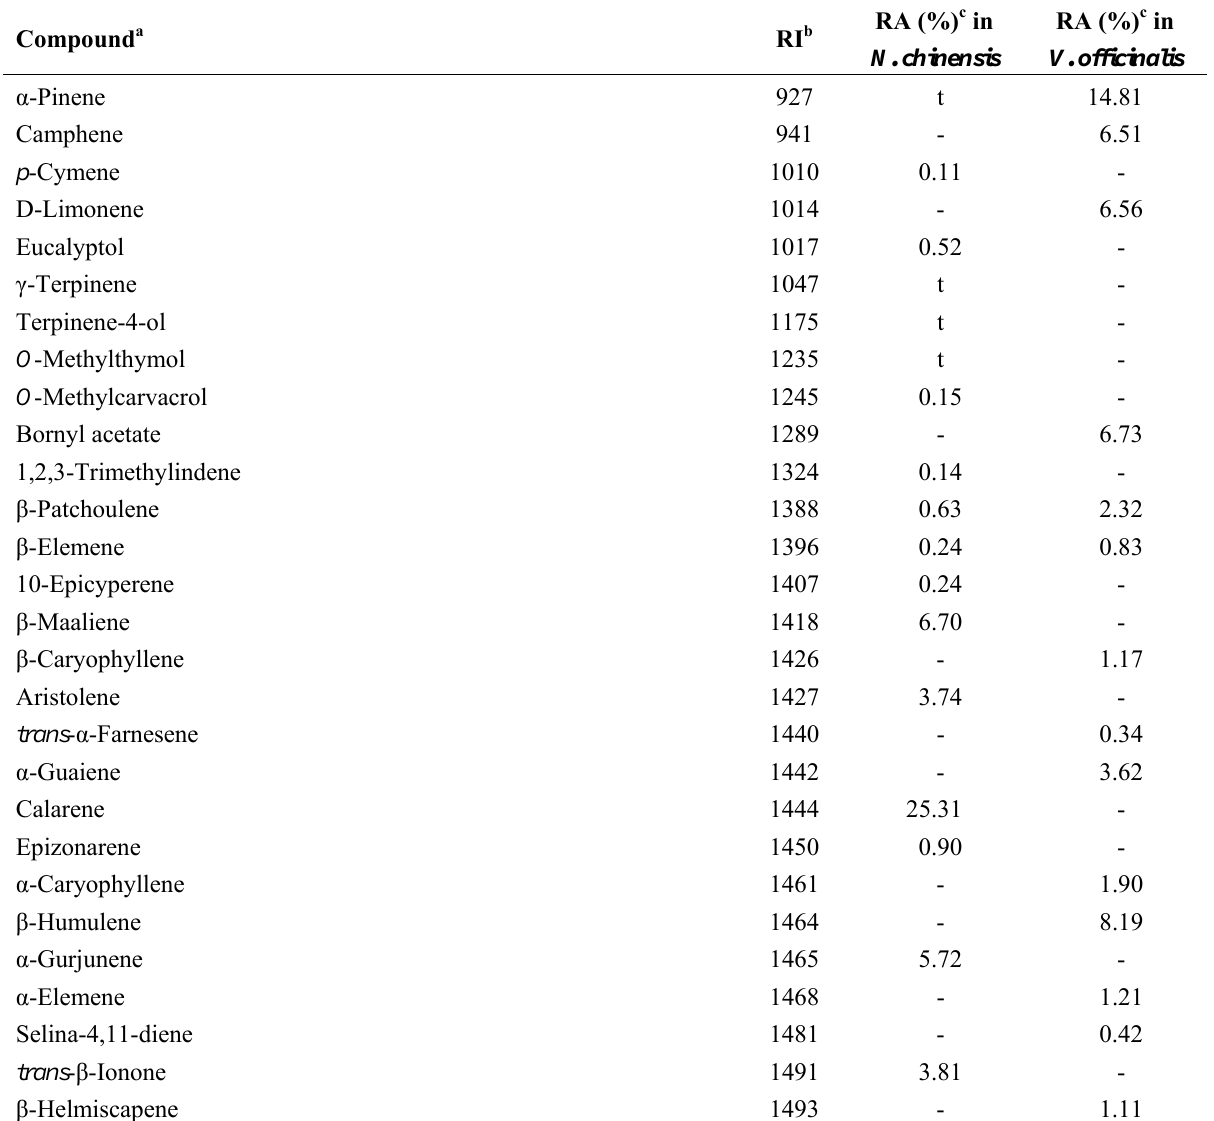
Table 1. Chemical composition of the essential oils from N. chinensis and V. officinalis . Compound